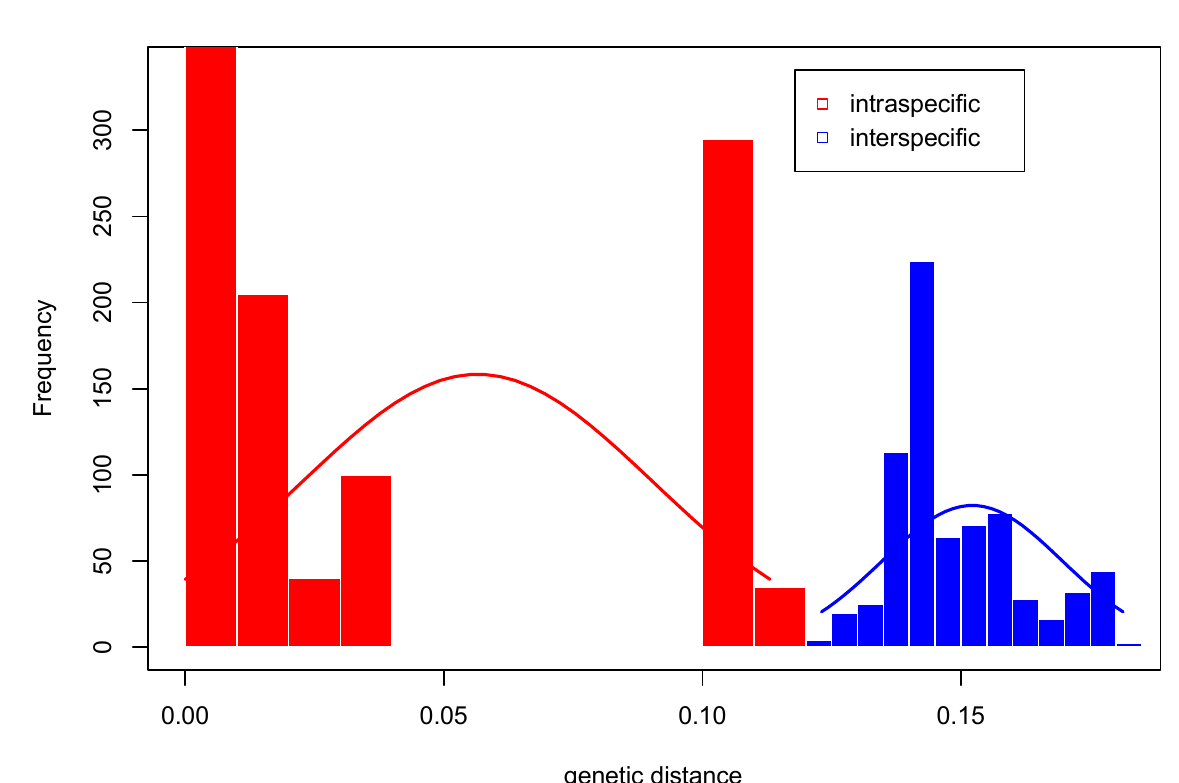
Figure A1. Histogram showing distributions of pairwise intra- and interspecific genetic distances (K2P values) for adult billbug specimens. A barcoding gap is demonstrated by non-overlapping distributions. The minimum, maximum and average interspecific distances were 0.123, 0.181, and 0.144, respectively. The minimum, maximum and average intraspecific distances were 0.000, 0.113, and 0.036, respectively.